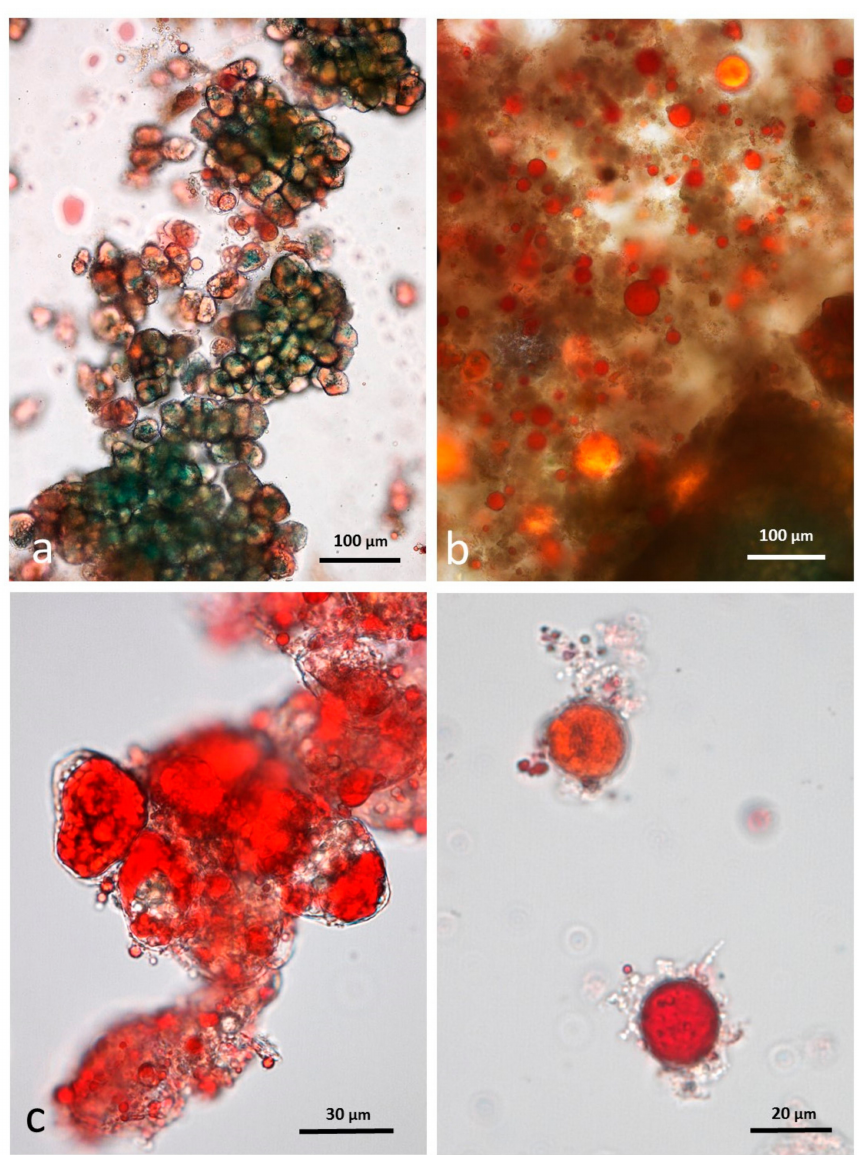
Figure 11. Faecal sample stained with Sudan IV from whole roasted almonds diet: ( a ) multicellular almond particles stained blue/green with marker dye; ( b ) free lipid drops; ( c ) coalesced lipid drops in cells; ( d ) lipid drops with adhering